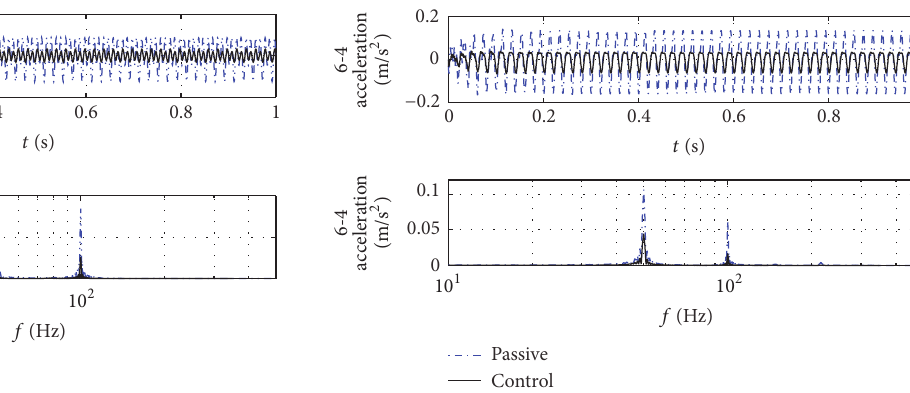
Figure 13: Comparison time-frequency domain curves of accelera- tion response of position 6-2 on the isolation system before and after being controlled under double sinusoidal interference.